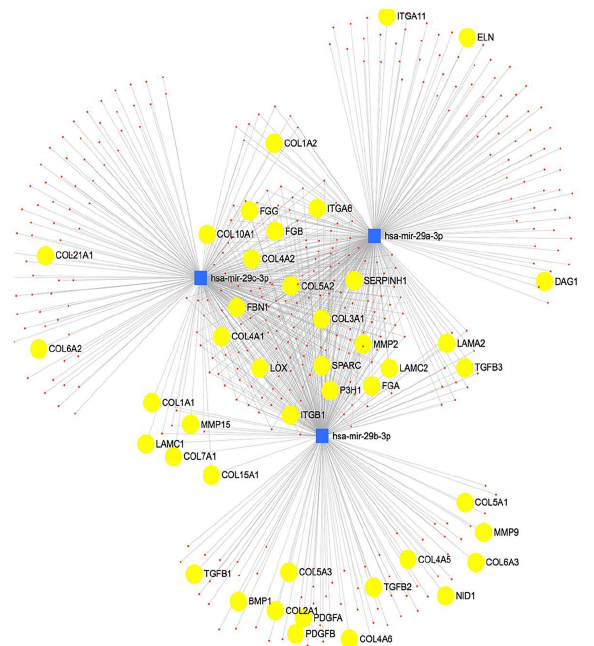
Figure 2. Network analysis of miR-29 regulated genes. miRNet was used to identify target genes regulated by the miR-29 family: miR-29a, miR-29b, and miR-29c. The miR-29 family interacts with several genes connected to ECM synthesis. miRNAs are represented in blue and target mRNAs are represented in